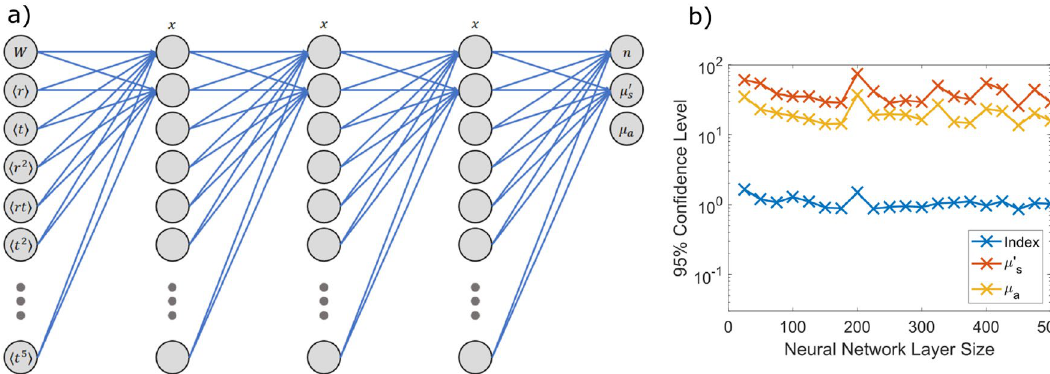
Figure 2. ( a ) Schematic of the fully connected neural network used to solve the inverse problem where x is varied to study the impact of network size on accuracy ( b ) The dependence of prediction accuracy on network layer size demonstrating that the prediction accuracy of the approach is not terribly sensitive to the size of the network used. This illustrates that this approach is a general one that is robust to small changes in network parameters. n is the index of refraction, µ s ′ is the reduced scattering coefficient defined in Eq. (7), and µ a is